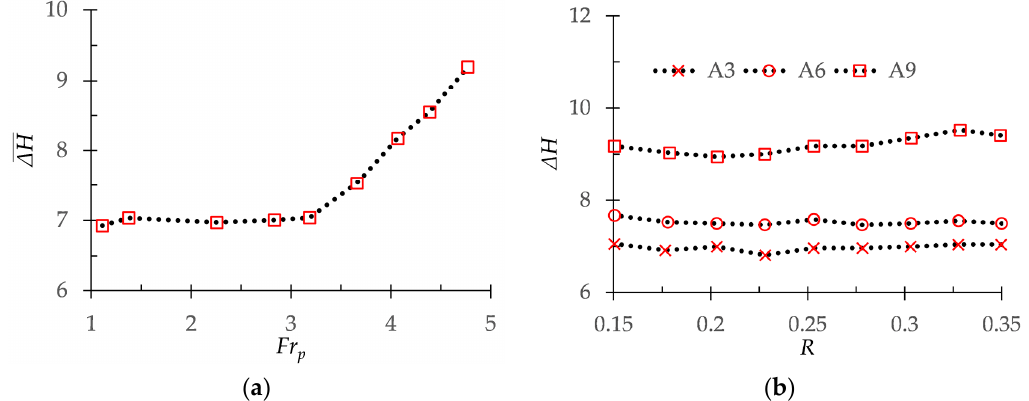
Figure 17. ( a ) Mean thicknesses of the pycnocline after the jet interaction with the pycnocline for 60 s. ( b ) The thickness distributions of the pycnocline in the range of 15 < R < 35 in cases A3, A6, and A9.